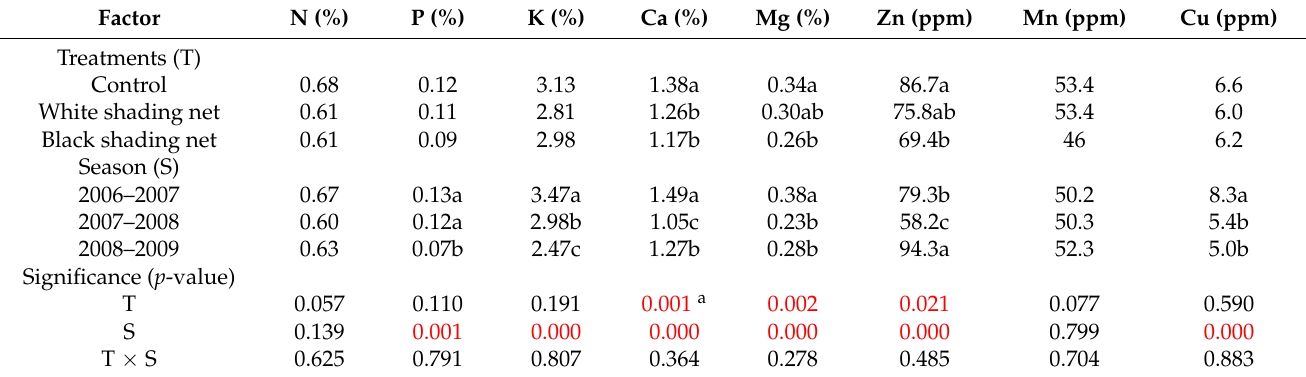
Table 6. Analysis of petiole nutrient content at flowering affected by shading net treatments and control in 2006–07, 2007–08 and 2008–09